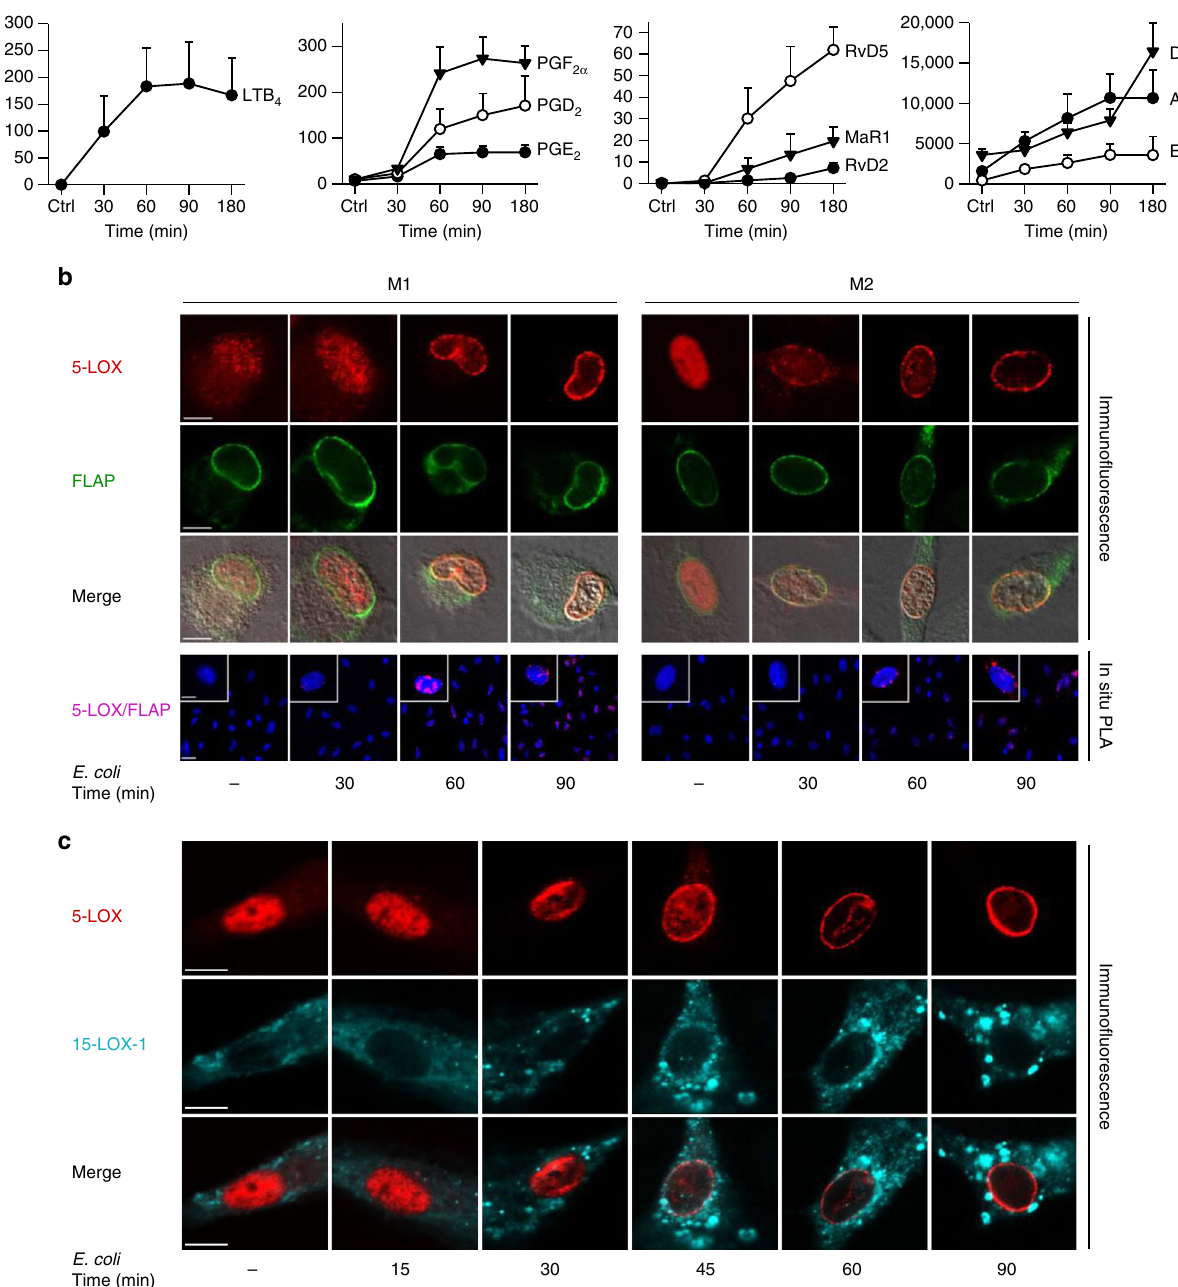
Fig. 5 Time course of E. coli -induced lipid mediator release and lipoxygenase activation. Human M1 or M2 (5× 10 6 cells/ml PBS+ Ca/Mg) was incubated with E. coli (O6:K2:H1; ratio = 1:50) at 37°C for the times indicated. As control (ctrl), cells were incubated at 37°C for 180min ( a ) or 90 min ( b , c ) without E. coli . a Formed lipid mediators in M2 were isolated by SPE and analyzed by LC – MS – MS. Data are given as means ± S.E.M., n = 3 separate donors. b , c Subcellular redistribution of 5-LOX and FLAP in M1 and M2 ( b ) or 5-LOX and 15-LOX-1 in M2 ( c ). After exposure to E. coli for the indicated times, cells were fi xed, permeabilized, and incubated with antibodies against 5-LOX (red), 15-LOX-1 (cyan-blue), and FLAP (green); scale bars = 5 µ m. b In situ interaction of 5-LOX and FLAP in M1 and M2 (lower panel); scale bars = 5 µ m (insets) and 10 µ m (overview). Proximity ligation assay (PLA) was performed after exposure of cells to E. coli after the indicated times. DAPI (blue) was used to stain the nucleus and in situ PLA signals (magenta dots) visualize 5-LOX/FLAP interaction. Results shown for one single cell are representative for ~100 individual cells analyzed in n = 3 independent experiments (separate